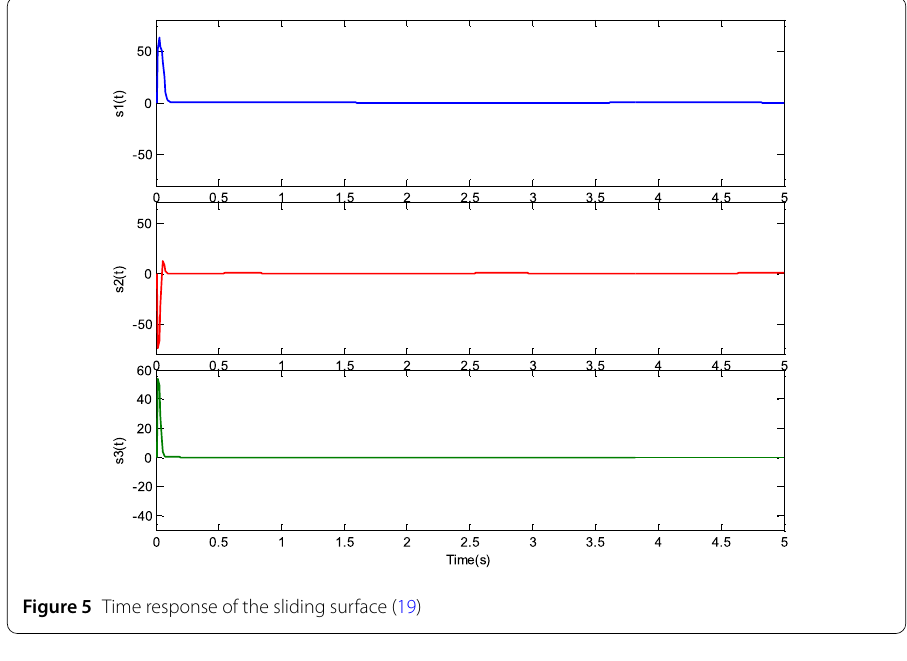
Figure 5 Time response of the sliding surface (19)